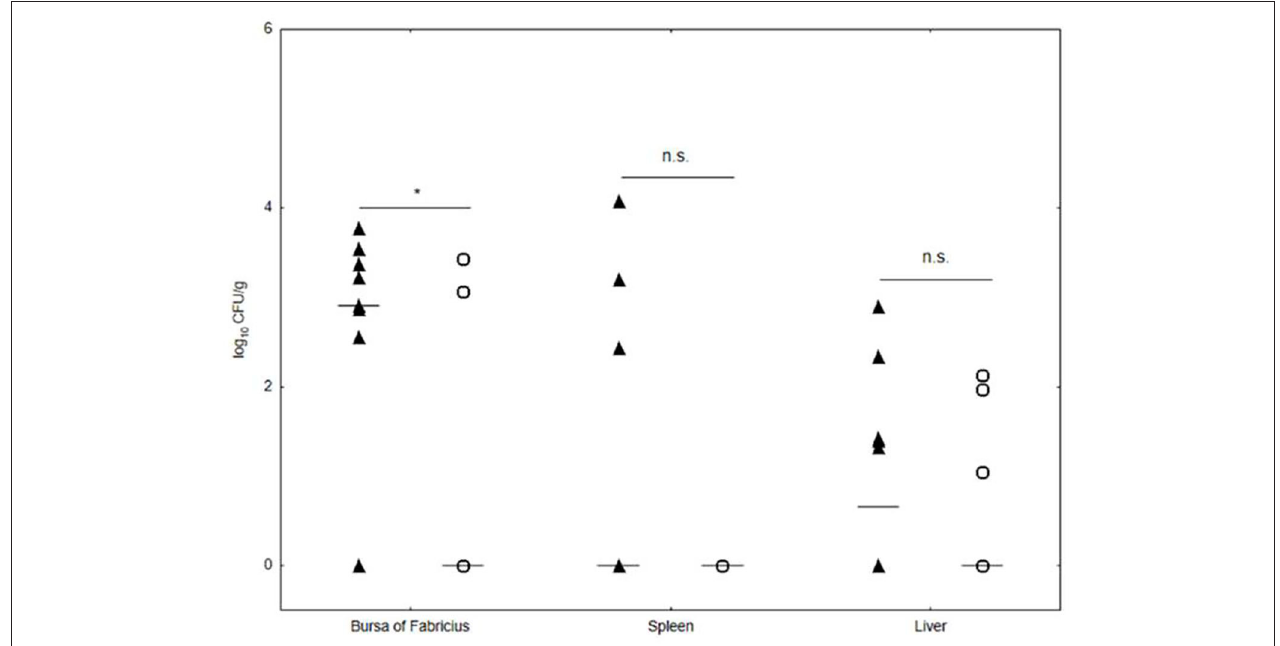
FIGURE 5 | Effect of phage cocktail UPWr_S134 on S. Enteritidis 327 lux number in internal organs in the experimental chicken model. Results for bacterial load are shown as counts for individual animals plus the median ( n = 10 per group). n.s., not significant, * p < 0.05 indicates a significant difference between control group 1 infected (black triangle) with S . Enteritidis 327 lux and the group 3 (empty circle) infected with S . Enteritidis 327 lux treated with phage cocktail